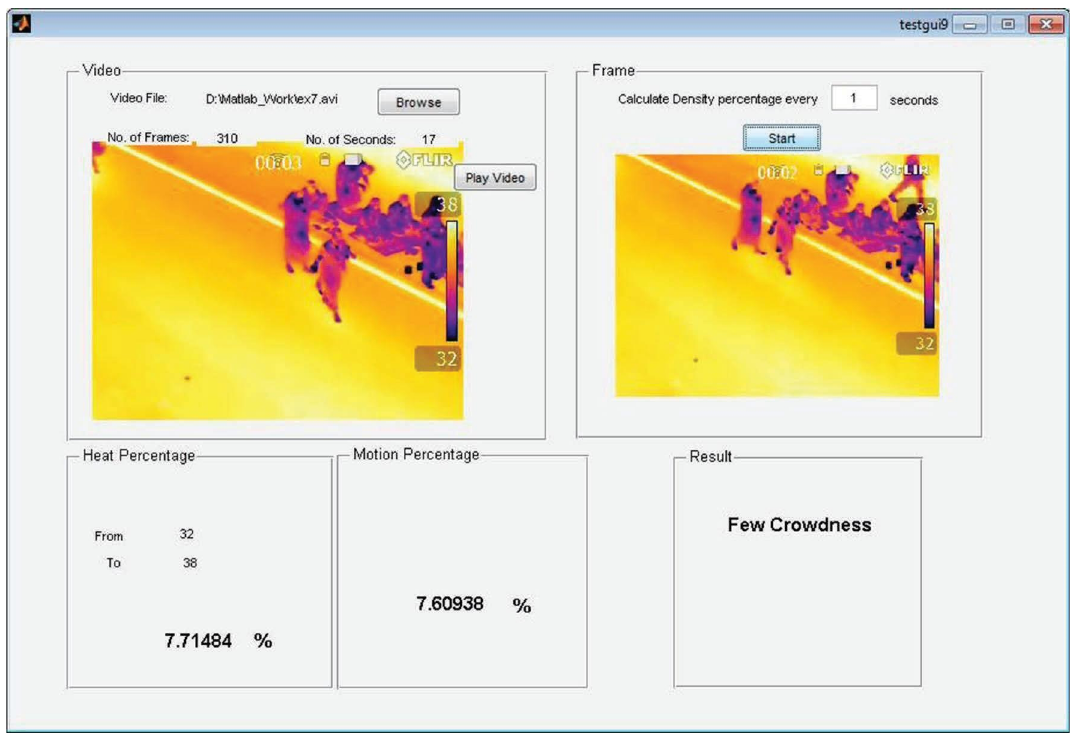
Figure 17: Sample result of real-time GUI for low crowd.